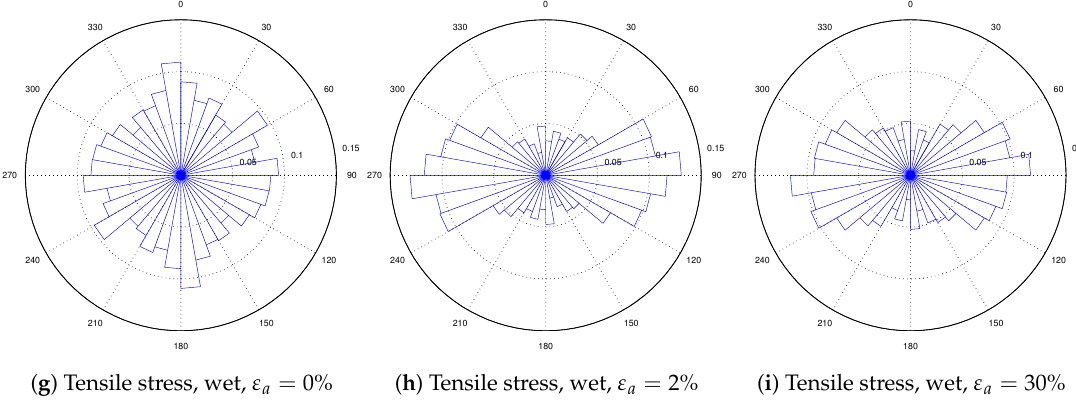
Figure 13. Directional distribution of compressive and tensile stress principal